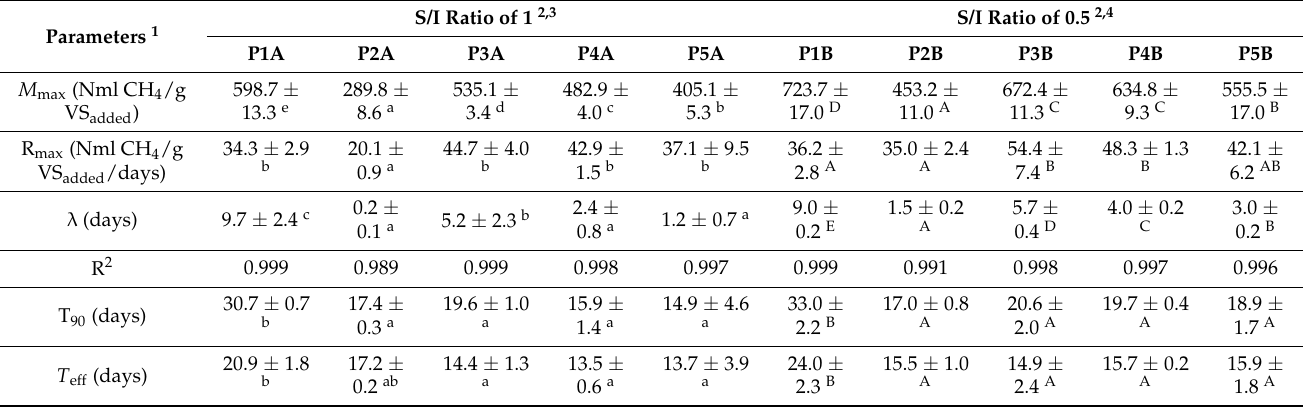
Table 6. Anaerobic digestion parameters from codigestion of SSW with SS. The SSW content in the codigested mixture